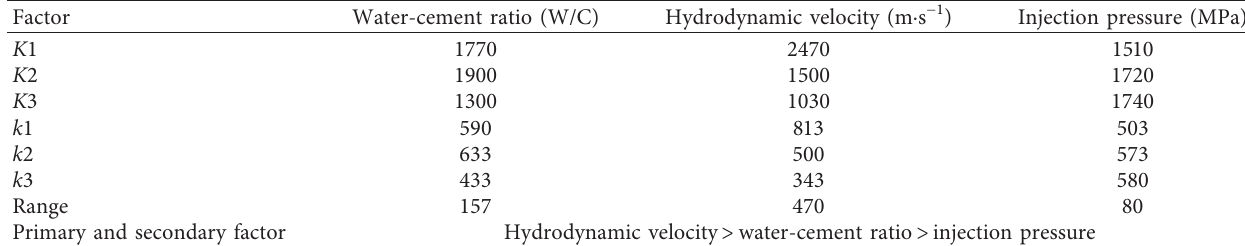
Table 6: Reverse diffusion distances in the 70 mm diameter pipe.